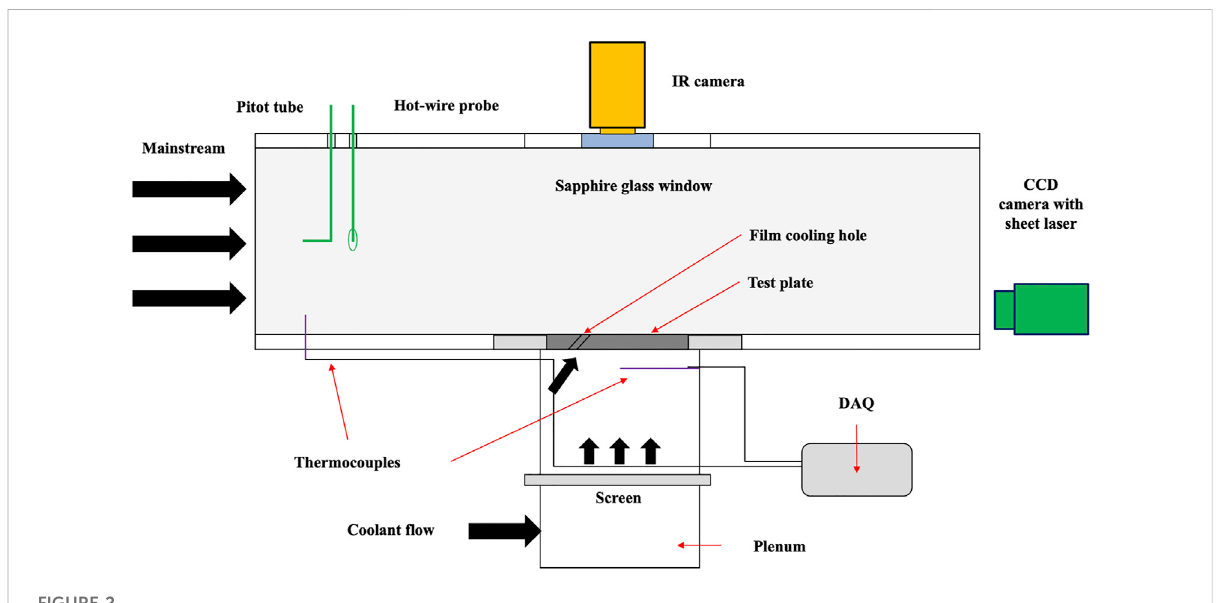
FIGURE 2 Schematic diagram of test section.